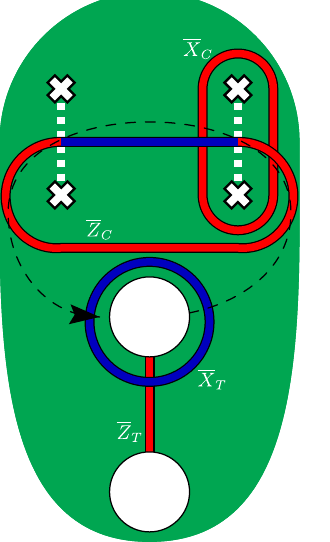
FIG. 11. The code-deformation scheme to entangle a qubit encoded with a pair of holes to a qubit encoded over four twists. At the top of the figure, we show the logical operators for a quadruple- twist qubit encoding, and at the bottom of the figure, we show the logical operators for a hole-pair qubit encoding. We present a scheme to perform a controlled-NOT gatewhere the qubit encoded with the four twists is the control qubit and the qubit encoded using holes is the target qubit. The black dashed line shows the trajectory that the hole in the middle of the figure must follow to complete a controlled-NOT gate between these qubits.